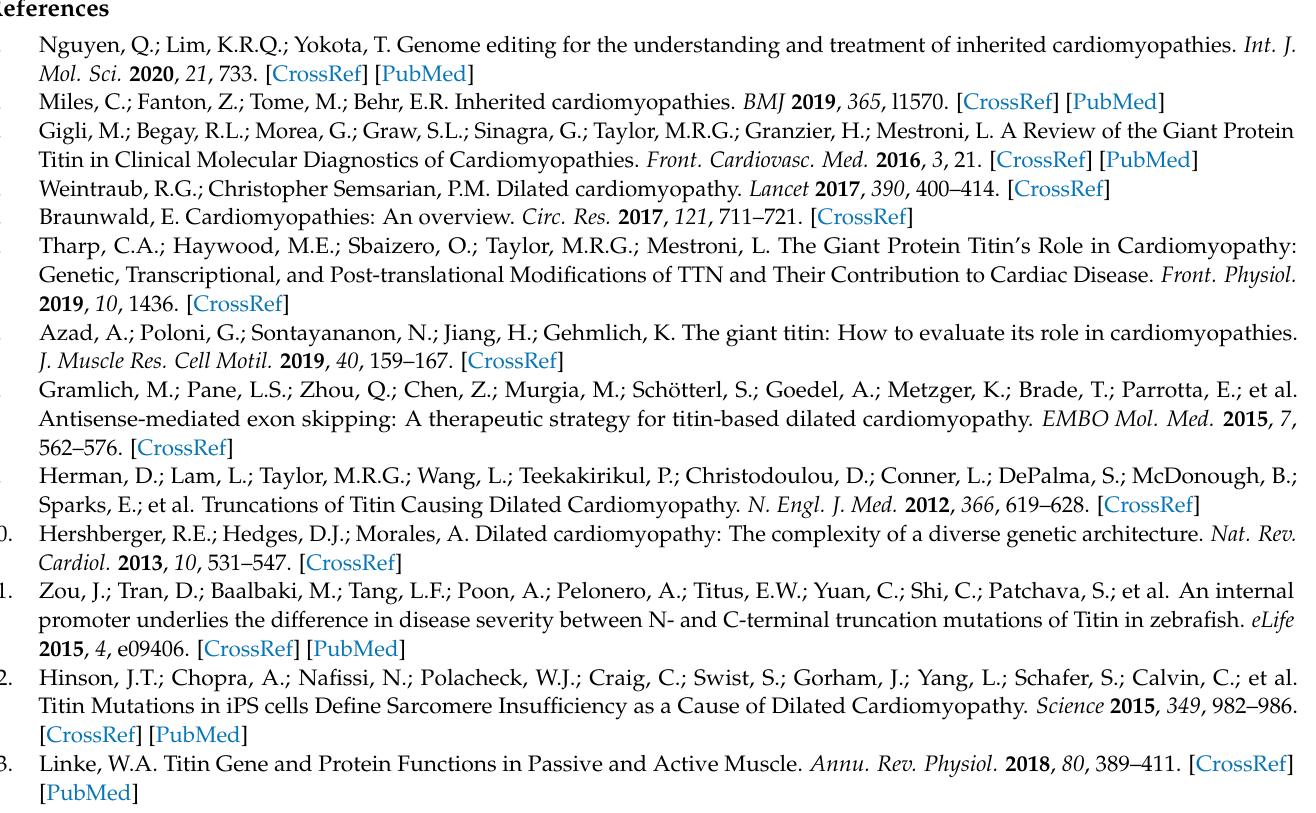
therapeutic removal; Table S2: Quantification of symmetric exons in selected cardiac relevant genes; Table S3: Symmetric exon quantification in the major TTN isoforms; Figure S1: Distribution of TTN exons according to their size; Table S4: Predicted alterations in TTN interactions with partner proteins result from candidate exon deletion; Figure S2: OBSCN exon analysis for therapeutic removal; Table S5: Symmetric exon quantification in the major OBSCN isoforms. Table S6: OBSCN list of candidate exons for